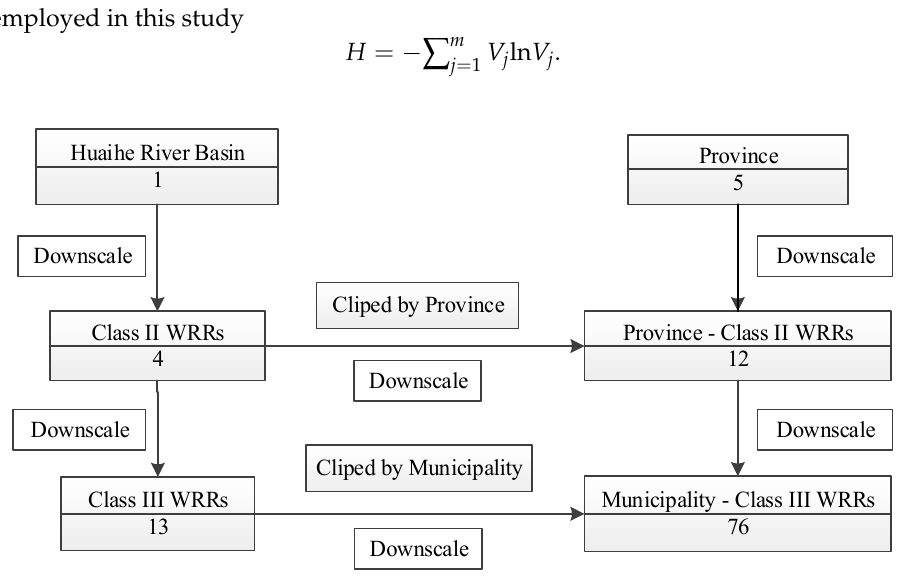
Figure 3. Multiscale assessment employed in this study.